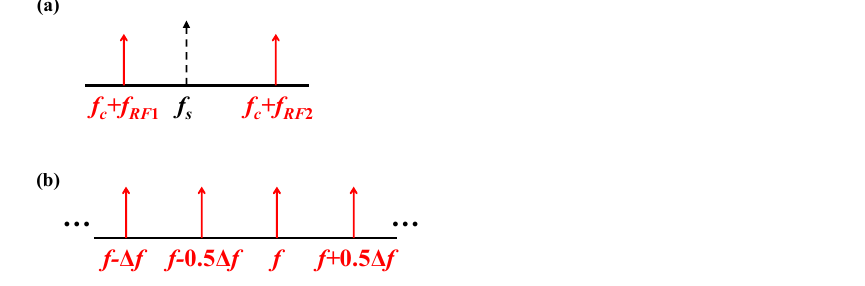
Figure 2. ( a ) Optical frequency of the ML and the SL. ( b ) Optical frequency of the SL in P2.